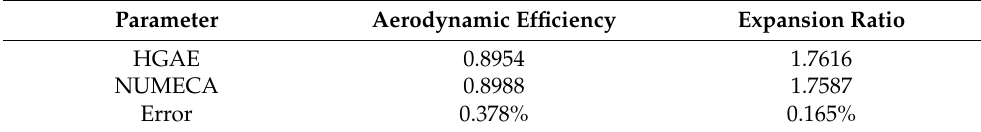
Table 3. Comparison of CFD Results.